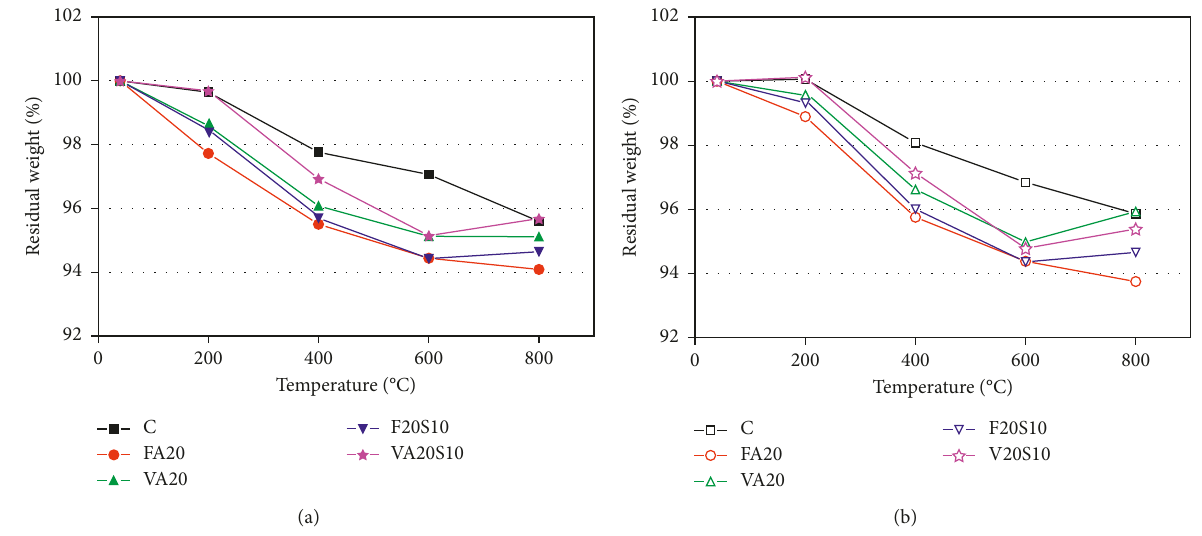
Figure 5: Residual weight of mortar specimens exposed to different fire temperatures: (a) air-cooled; (b) water-cooled.